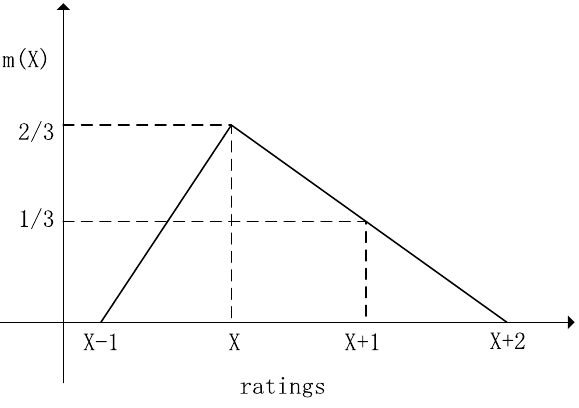
Figure 2. Construct new BPAs with triangular fuzzy